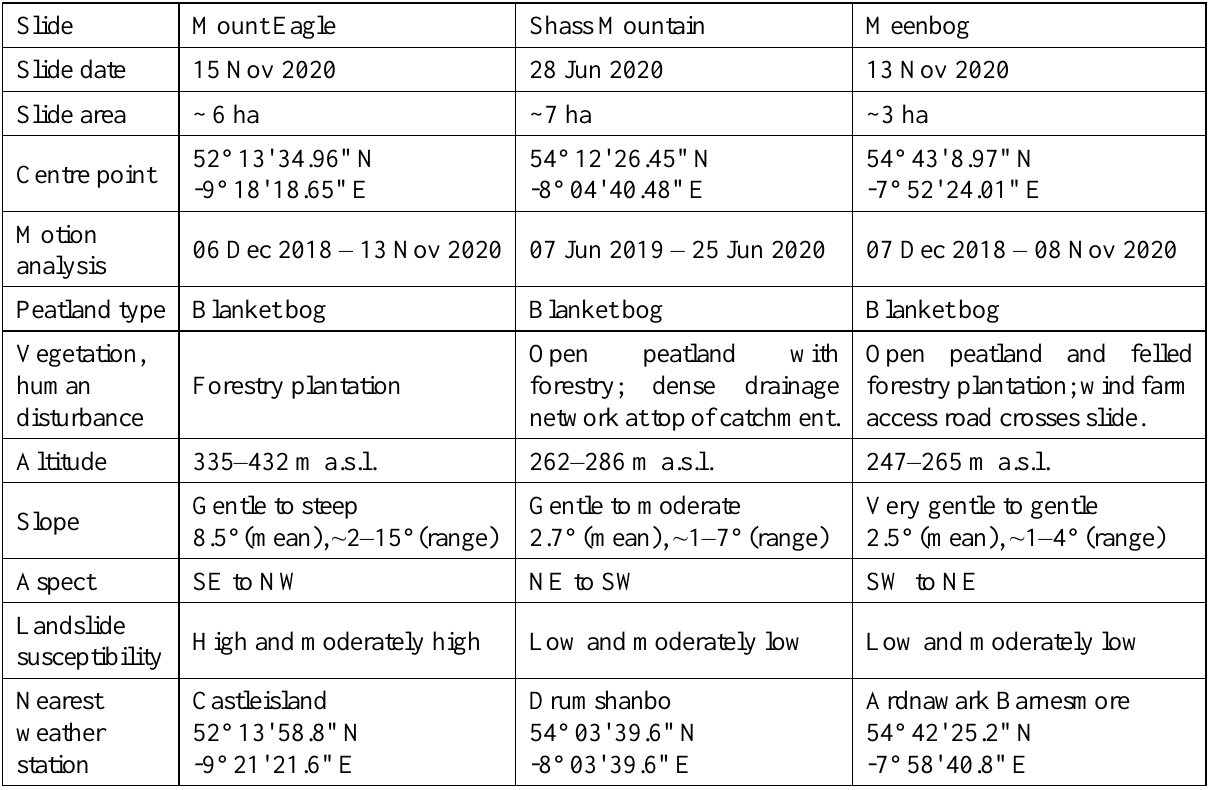
Figure 1. Maps of Ireland showing (a) the locations of the three peat failures analysed (red dots) and their closest weather stations (black dots), and (b) the investigation sites on upland areas with blanket bog around Lough Allen that were selected to demonstrate the mapping of peat slide risks. Contour interval 100 m. Table 1. General characteristics and information relevant to the three peat slides analysed. Altitude and slope are derived from 30 m resolution SRTM data (Farr et al. 2007). Landslide susceptibility is taken from Geological Survey Ireland